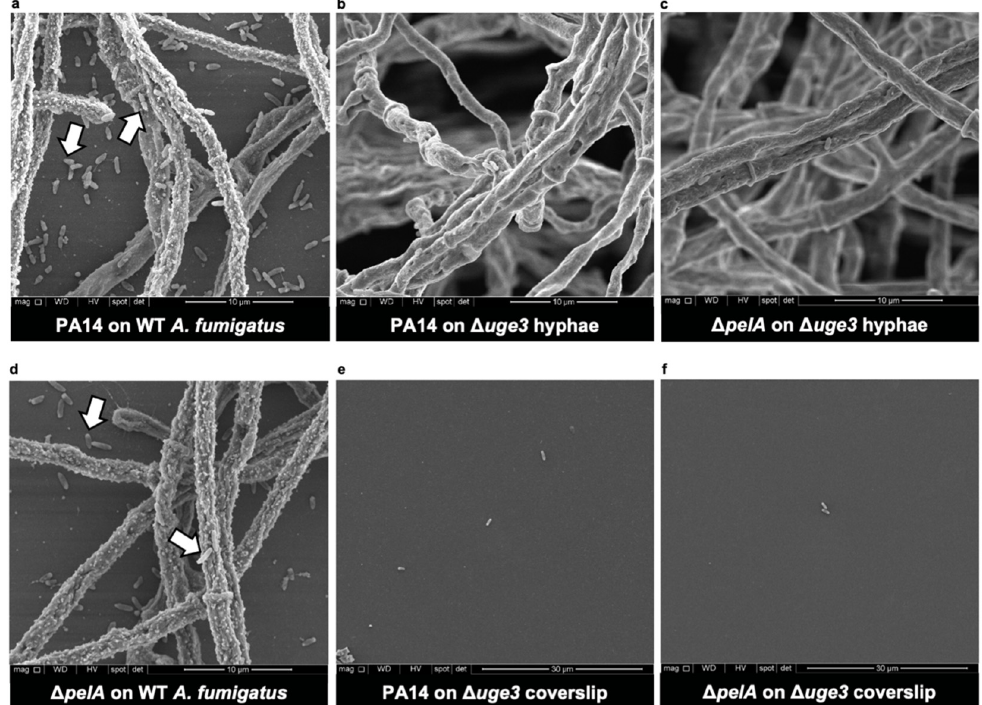
Figure 3. GAG mediates the adherence of P. aeruginosa to A. fumigatus hyphae. Scanning electron microscopy images of co-cultures of wild-type P. aeruginosa (PA14) with ( a ) adherent wild-type (WT) A. fumigatus hyphae on coverslips or ( b ) non-adherent GAG-deficient A. fumigatus hyphae ( Δ uge3 ). Co-cultures of Pel-deficient P. aeruginosa ( Δ pelA ) with ( c ) non-adherent GAG-deficient A. fumigatus hyphae ( Δ uge3 ) or with ( d ) adherent wild-type A. fumigatus hyphae (WT) on coverslips. ( e ) Coverslip of ( b ) and ( f ) coverslip of ( c ). Representative images of 2 independent experiments. ( a – d ) Imaged at 10,000×. ( e , f ) Note a lower magnification at 5000×. White arrows indicate adherent bacteria to hyphae and coverslips in the interstitial spaces between hyphae.